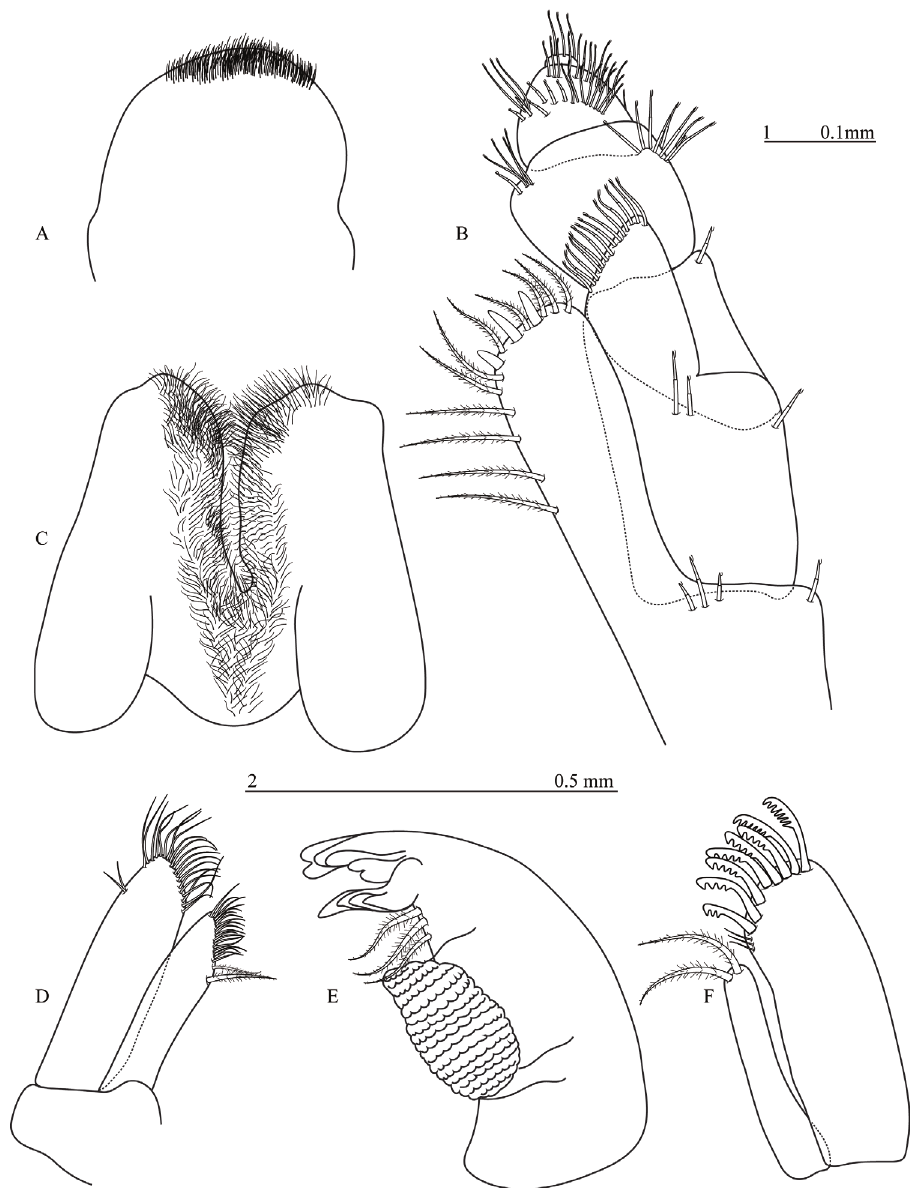
Fig. 2. Cerrorchestia taboukeli sp. nov., holotype, ♂, 11.3 mm, MNHN-IU-2019-2276. A . Upper lip (scale 2). B . Maxilliped (scale 1). C . Lower lip (scale 2). D . Maxilla 2 (scale 2). E . Left mandible (scale 2). F . Maxilla 1 (scale